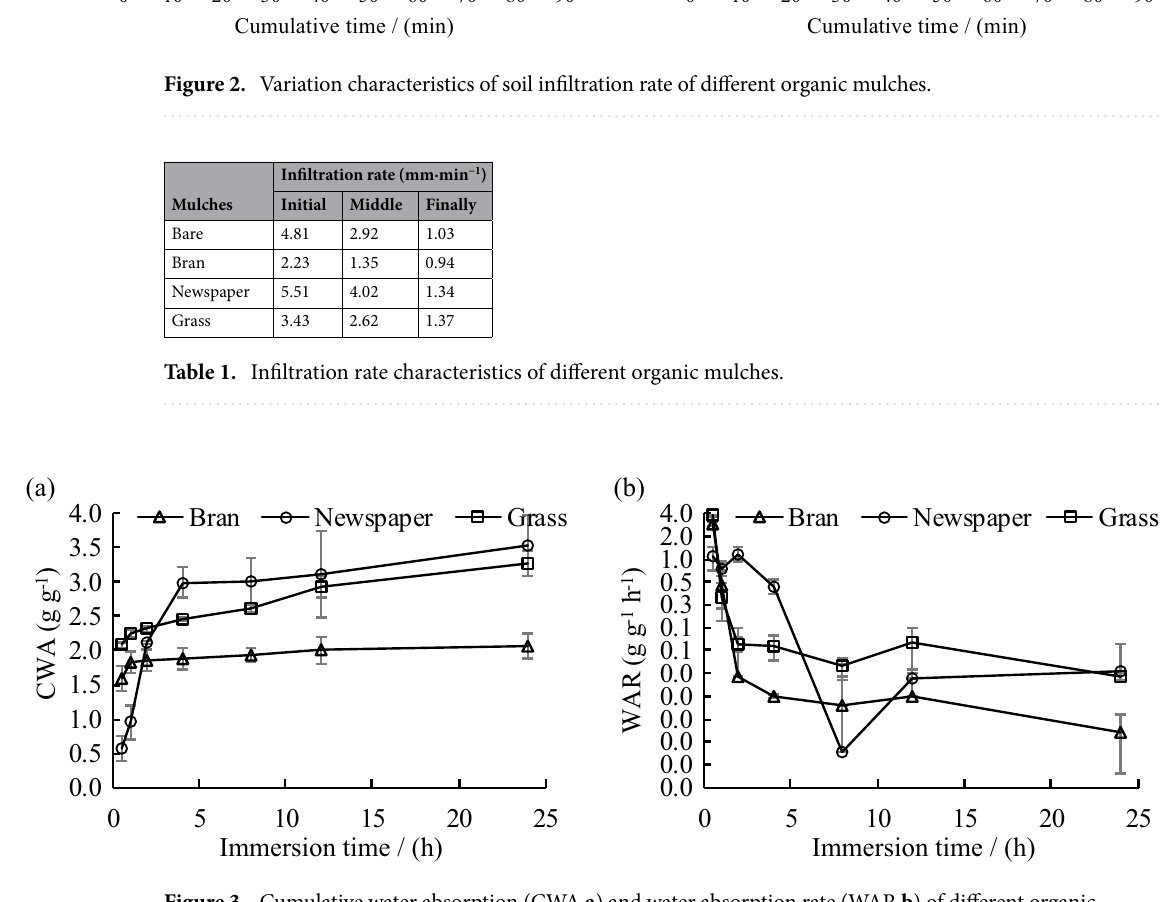
Figure 3. Cumulative water absorption (CWA a ) and water absorption rate (WAR b ) of different organic